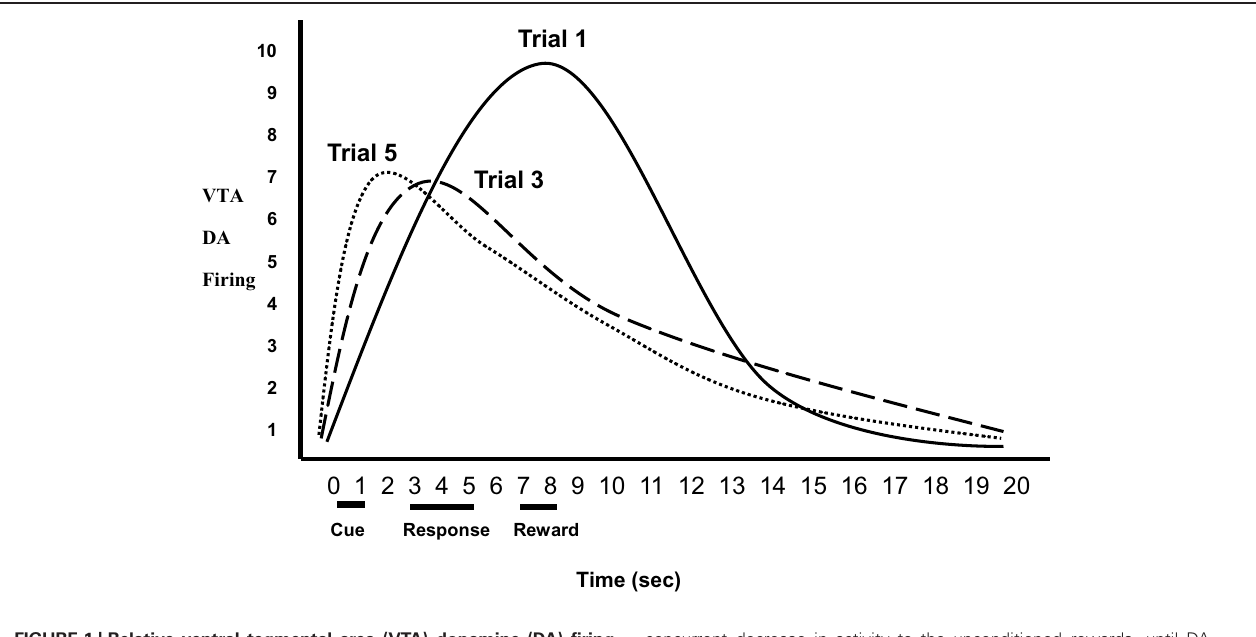
FIGURE 1 | Relative ventral tegmental area (VTA) dopamine (DA) firing as a function of trial. VTA DA neurons show increased activity in the presence of neutral stimuli that consistently predict reward, and a